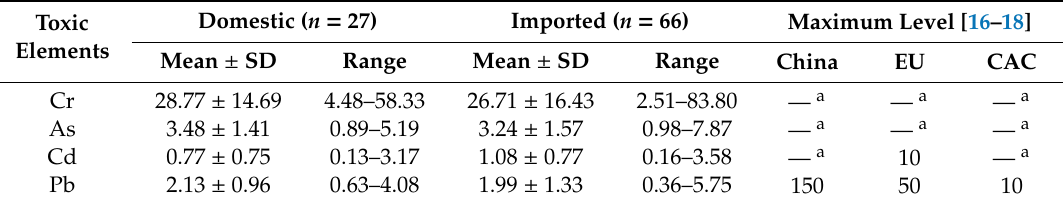
Table 5. Toxic elements content ( µ g / kg) in domestic and imported infant